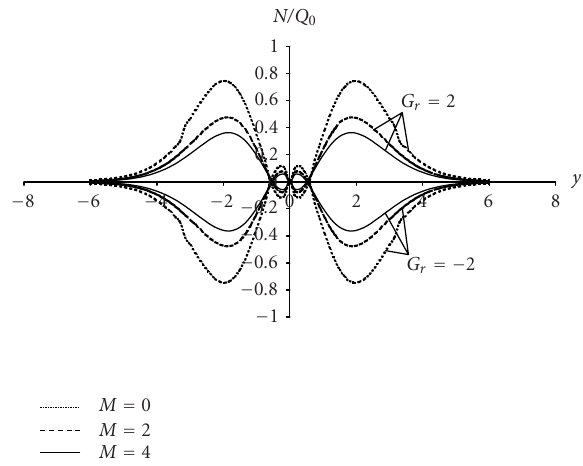
Figure 7.5. The angular velocity distribution for di ff erent values of M for the whole-space problem.